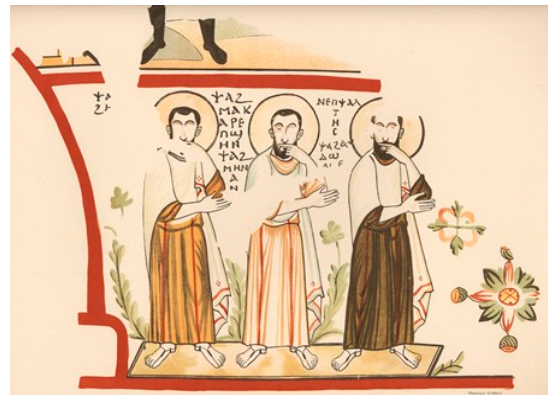
Figure 23. Bawit Monastery. Chapel 28. Egypt. Aquarelle copy. After (Clédat 1904).